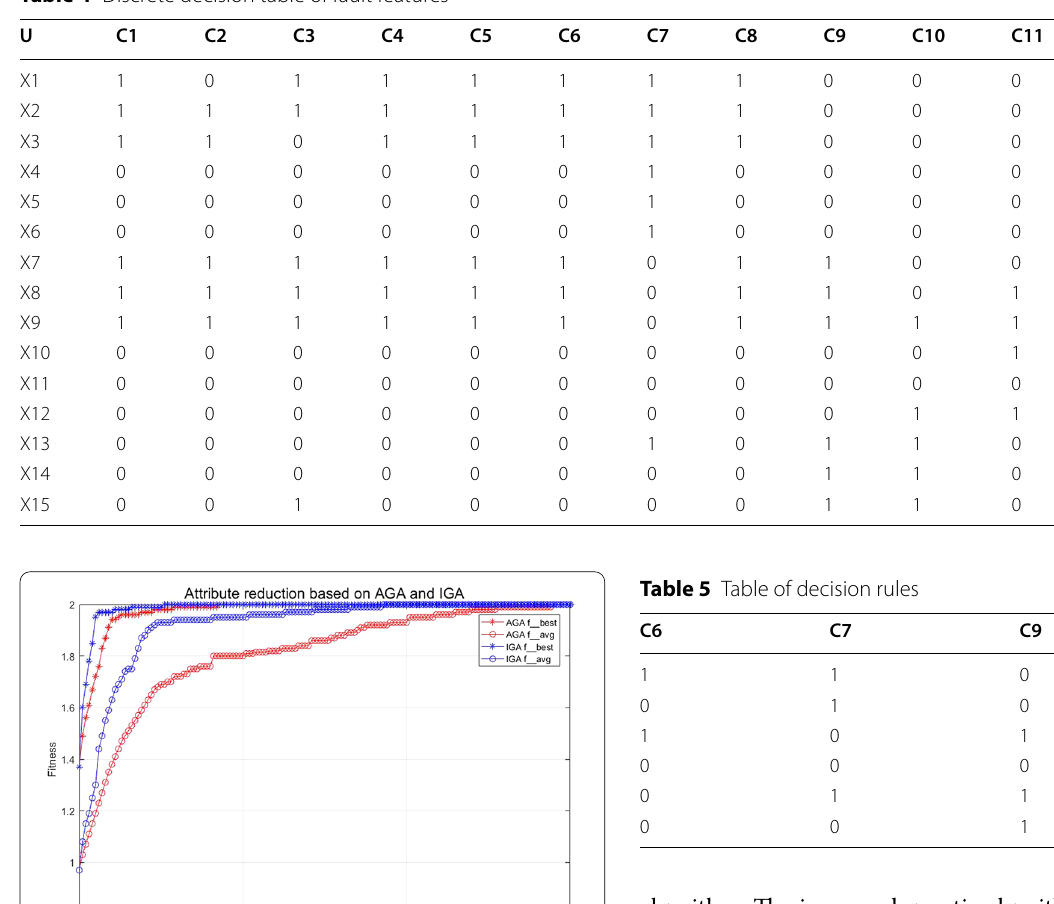
algorithm. The improved genetic algorithm converges to